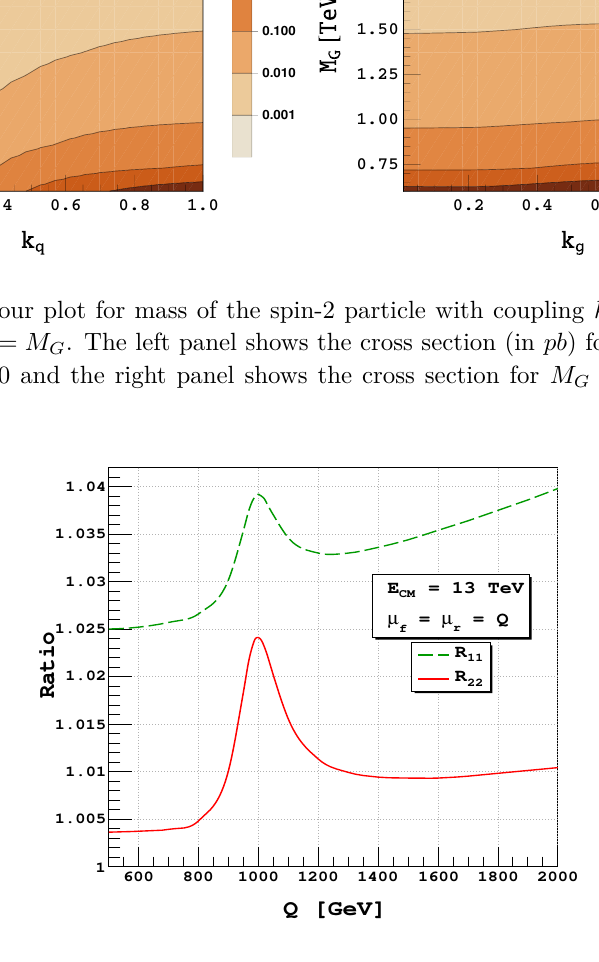
Figure 5 . Comparison between fixed order results and resummed results. The ratios are defined with respect to NLO as described in the